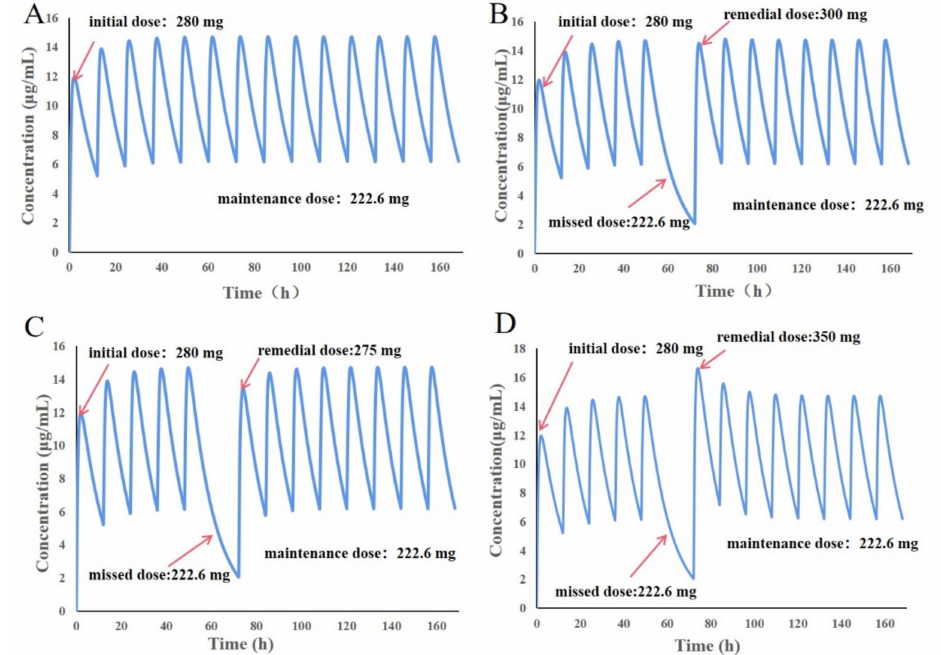
Figure 9. Prediction results of the 280 mg + 222.6 mg oral LEV-PBPK model in 6-year-old Chinese children. ( A ) Seven-day drug–time curve after normal administration; ( B ) 300 mg drug–time curve after remediation of a missed dose; ( C ) 275 mg drug–time curve after a missed dose; ( D ) 350 mg drug–time curve after remediation of a missed